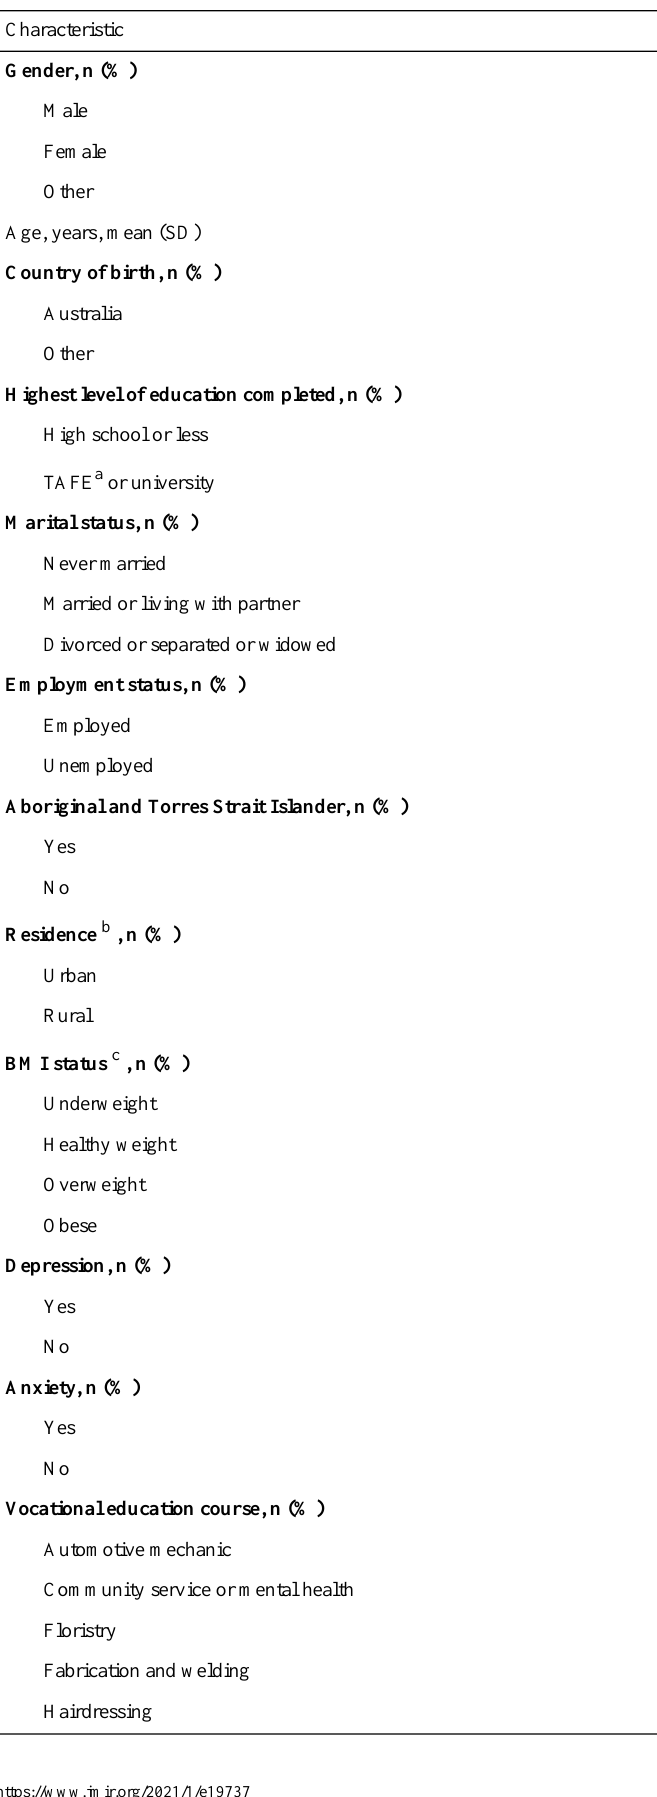
Table 2. Sociodemographic, BMI, psychological characteristics, and vocational education courses of the sample